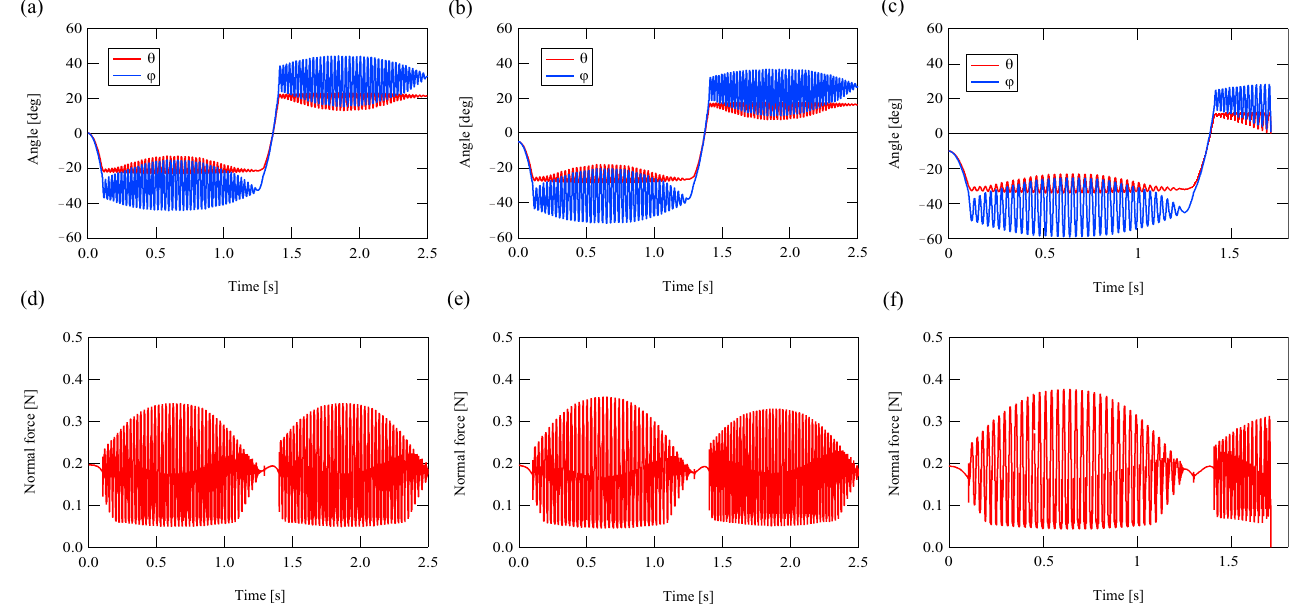
Figure 7. Behavior of wiper blade zero and nonzero attack angle. ( a ) Angular displacements of two links with zero attack angle. ( b ) Angular displacements of two links with 5-degree attack angle. ( c ) Angular displacements of two links with 10-degree attack angle. ( d ) Normal force of wiper blade with zero attack angle. ( e ) Normal force of wiper blade with 5-degree attack angle. ( f ) Normal force of wiper blade with 10-degree attack angle.